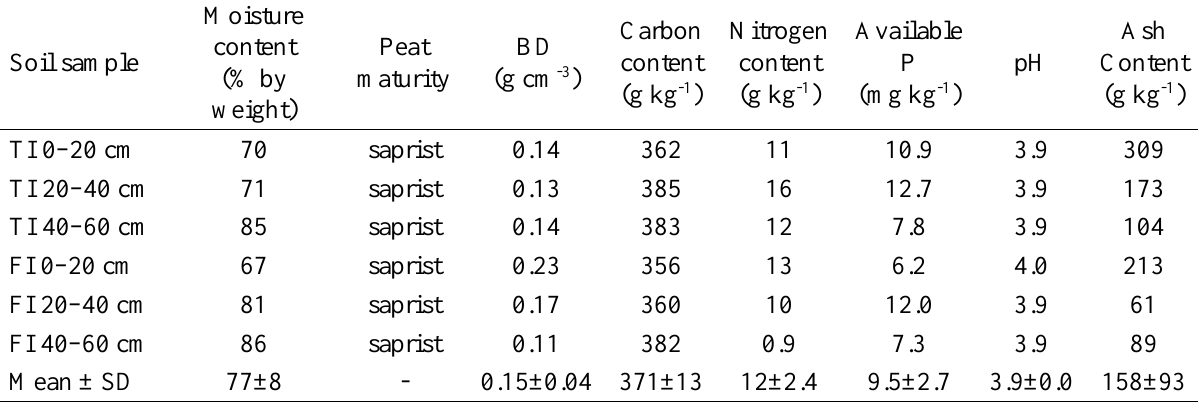
Table 1. Peat properties at different depths, from samples in the traffic interrow (TI) and the palm frond interrow (FI). SD = Standard deviation; BD = Bulk